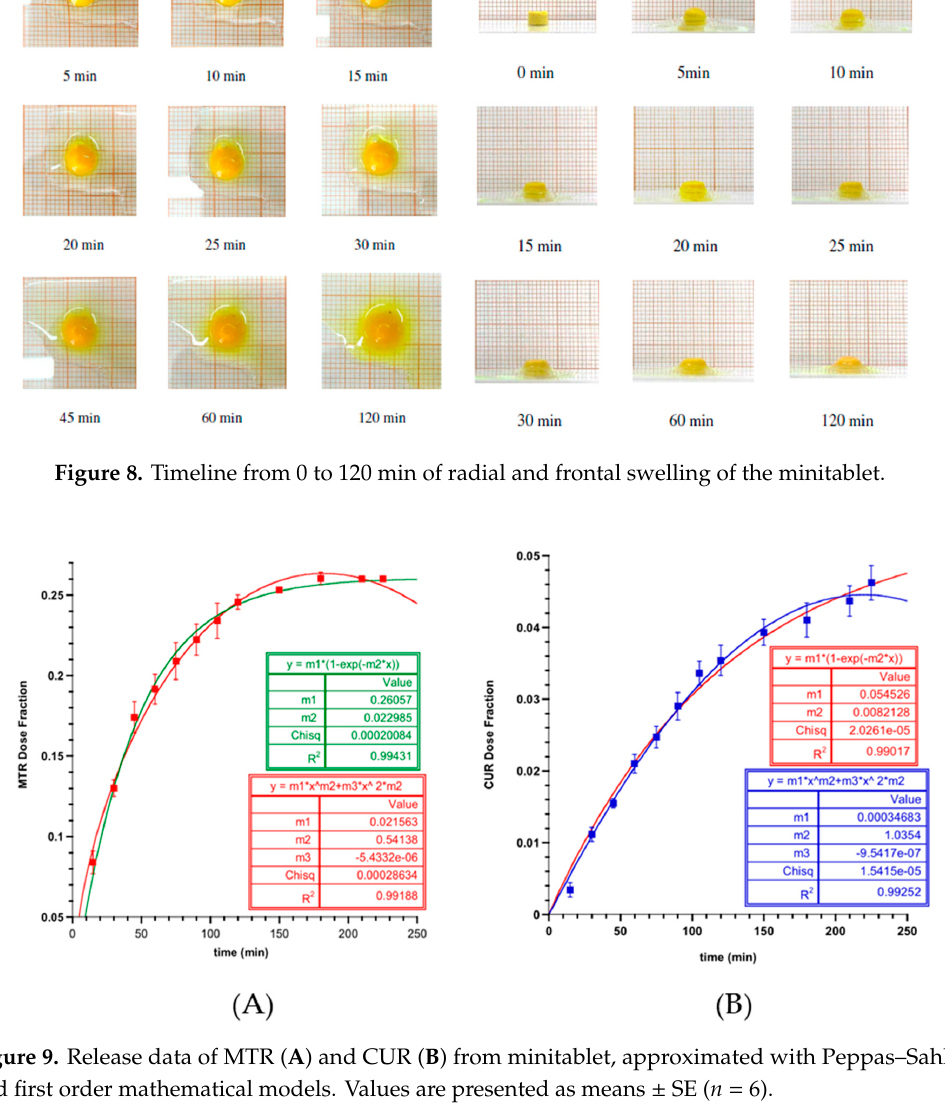
Figure 9. Release data of MTR ( A ) and CUR ( B ) from minitablet, approximated with Peppas–Sahlin and first order mathematical models. Values are presented as means ± SE ( n =